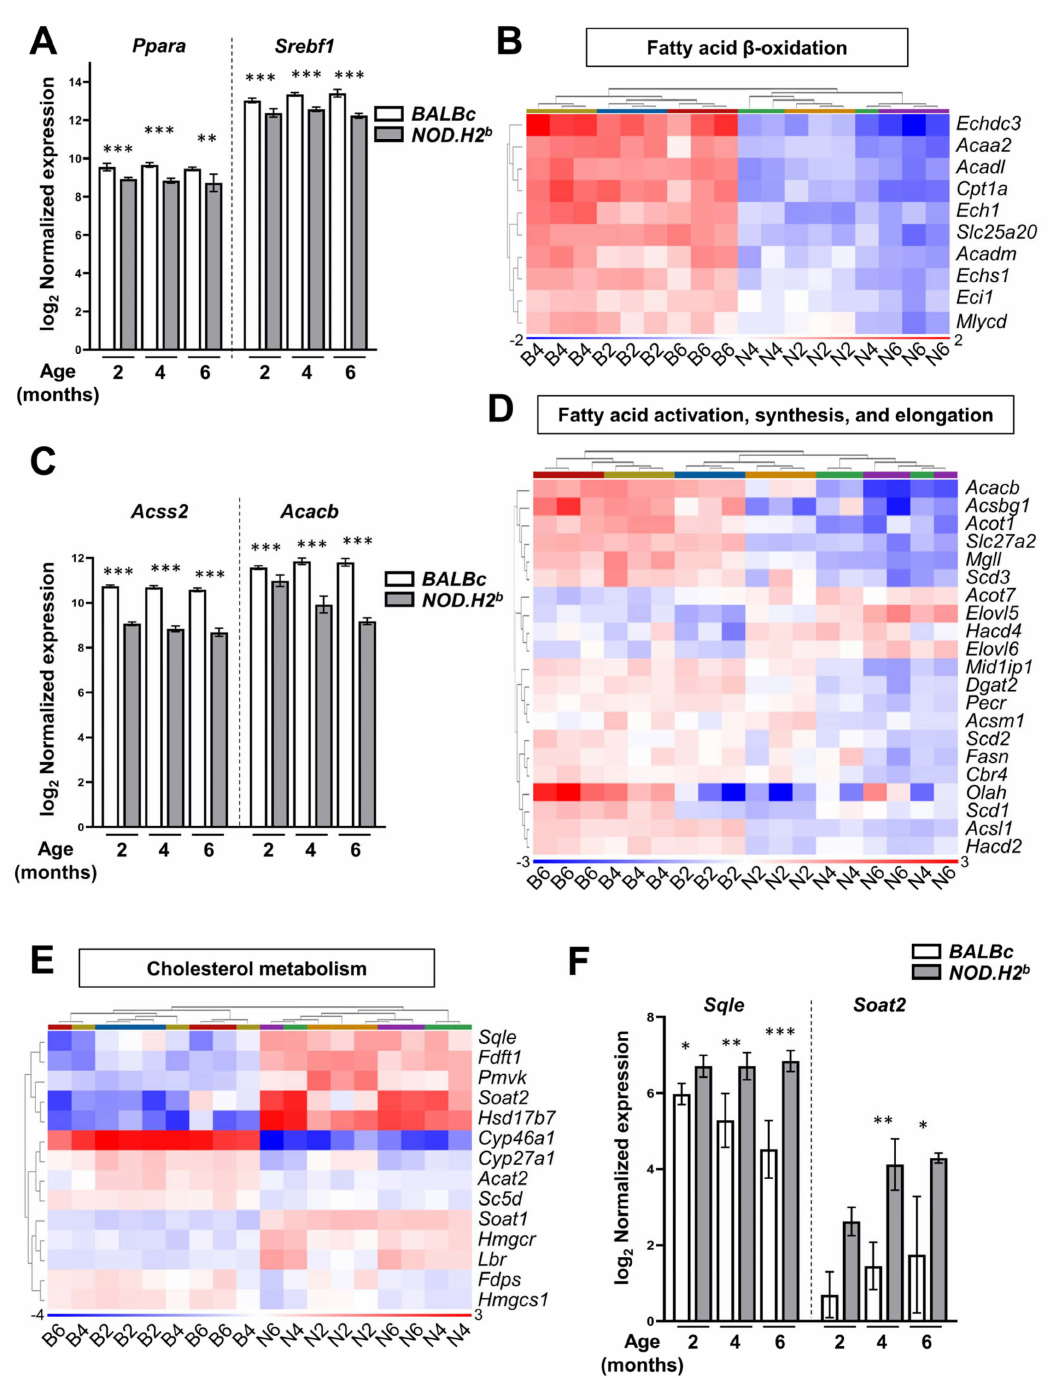
Figure 7. Chronic inflammation upregulates enzymes related to cholesterol production but down- regulates fatty acid metabolism. RNA-seq data of LGs from NOD.H2 b and BALBc mice. Bar plots show the normalized mRNA expression while heatmaps compare expression levels of genes involved in ( A ) the regulation of lipogenic genes, ( B ) mitochondrial fatty acid β -oxidation, ( C , D ) fatty acid activation, synthesis, and elongation and ( E , F ) cholesterol metabolism. Heatmap sample legends correspond to B = BALBc and N= NOD.H2 b , followed by mouse age in months. Error bars show the mean (SD). Significant differences are represented as * if p value p < 0.05, ** if p < 0.01, and *** if p <